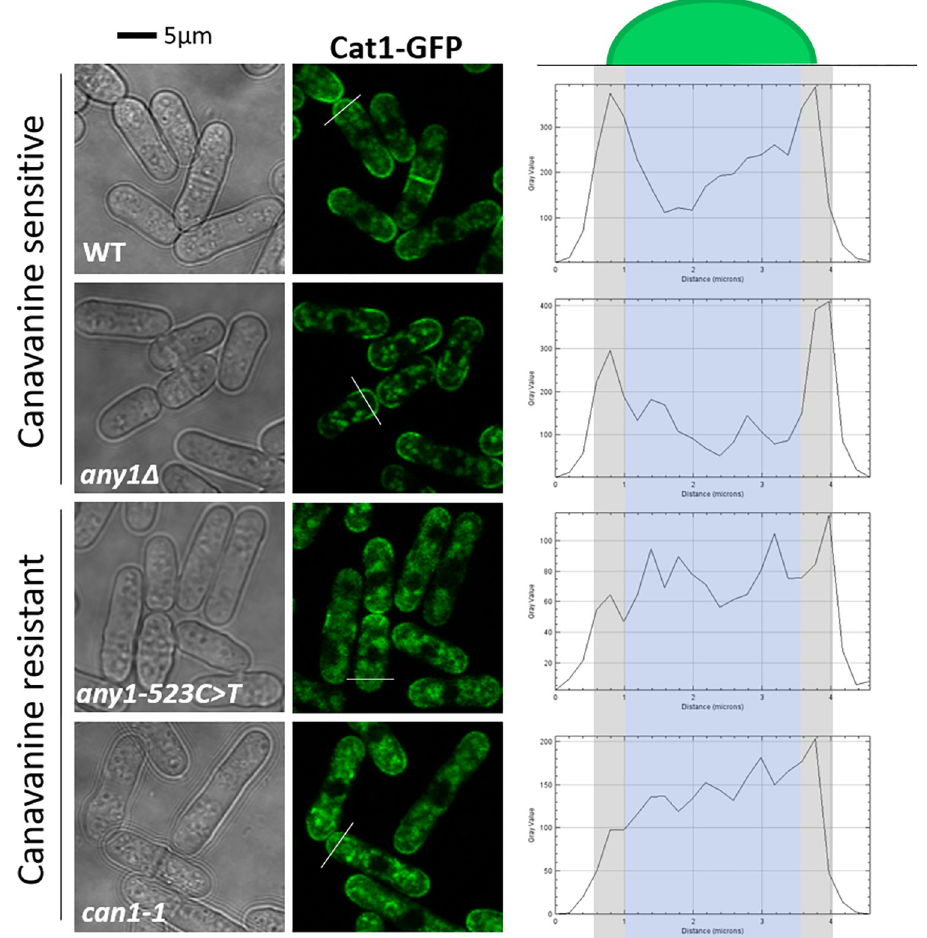
Fig 5. Expression of Any1-R175C leads to Cat1 internalization. Cellular localization of Cat1-GFP in indicated strains. Left panel: cells expressing Cat1-GFP observed under a fluorescence microscope. Right panel: intensity of GFP signal across the cell (white bar on the left panel). Strains used: KT1345, KT1348, KT1352,